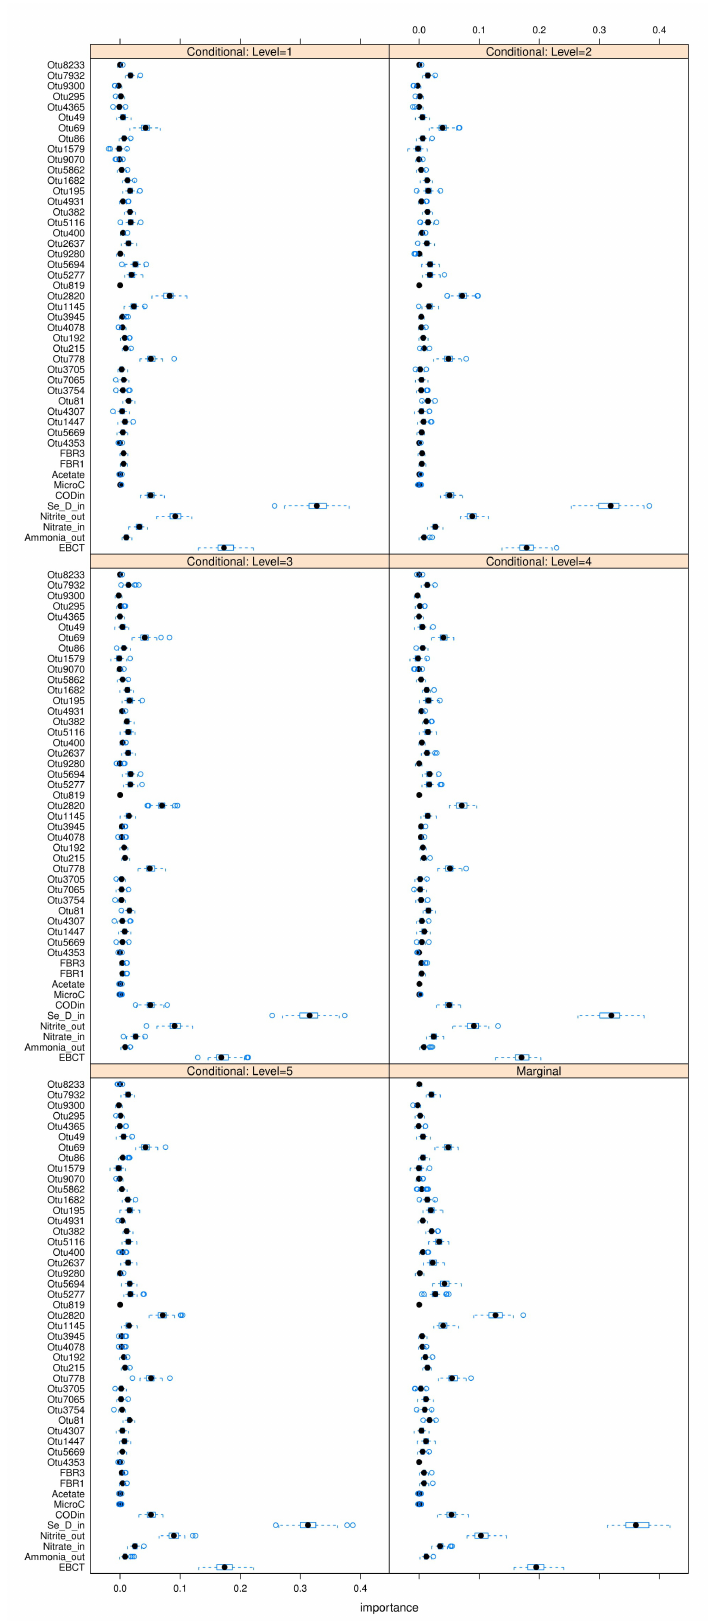
Figure A25. Conditional feature importances for Dirichlet multinomial mixture (DMM)